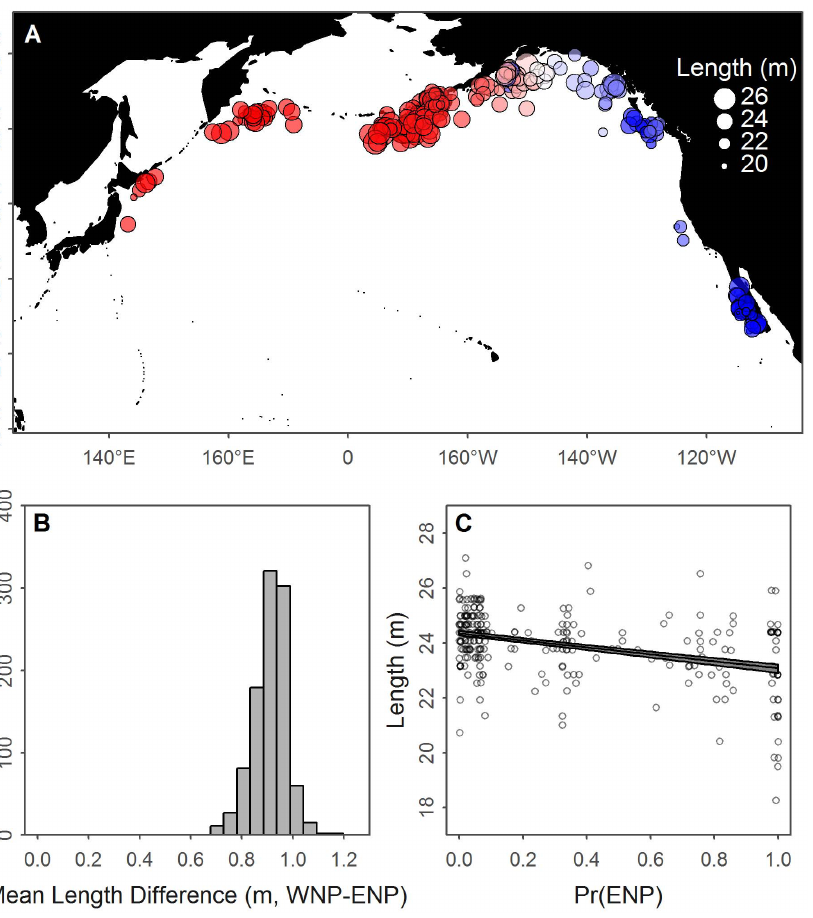
Figure 14. Results of the length analysis of mature female blue whales. (A) Locations, lengths, and median predicted population (color) for all years. (B) The distribution of mean length differences for all bootstrap iterations. (C) The 95% percentiles (gray polygon) and median line for all bootstrap linear models fit to the predicted population versus lengths. The circles represent the median probability of being ENP and observed lengths and are plotted with a small amount of noise to prevent